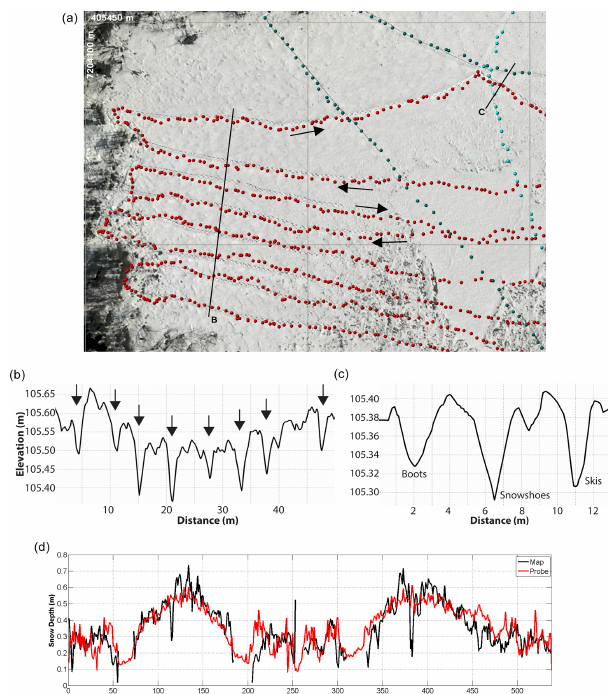
Figure 4. (a) The subset of the winter orthoimage of Minto Flats air- borne map area where ground measurements were made. The UTM 6N graticule with 50m spacing provides scale. Snow probe GPS lo- cations (dots colored by probe user) were always within 3m of the footprints seen on the orthoimage acquired the next day. The tran- sects labeled (b) and (c) indicate the start of the depth cross-sections shown in (b) and (c) . In (b) the section clearly shows the footsteps caused by an operator wearing snowshoes (arrows). In (c) the sec- tion indicates our photogrammetric mapping can actually resolve differences in foot wear and snow compaction; note the change in vertical scale from (b) . (d) Four back-and-forth transects of prob- ing have been unfolded here (as indicated by arrows in a ); these transects continue off the right side of the image about twice as far as seen in (a) ; thus probe #’s 0–50, 200–300, and 450–550 are not shown in (a) . The coincidence between probe and photogrammetric snow depths is remarkable. Missing map values occur where there was open water in summer. The deepest snow was found near the forest edge (at left in a ). Here taller shrubs and grasses were com- pressed the most by winter snow cover, causing a real map differ- ence in addition to the snow thickness change